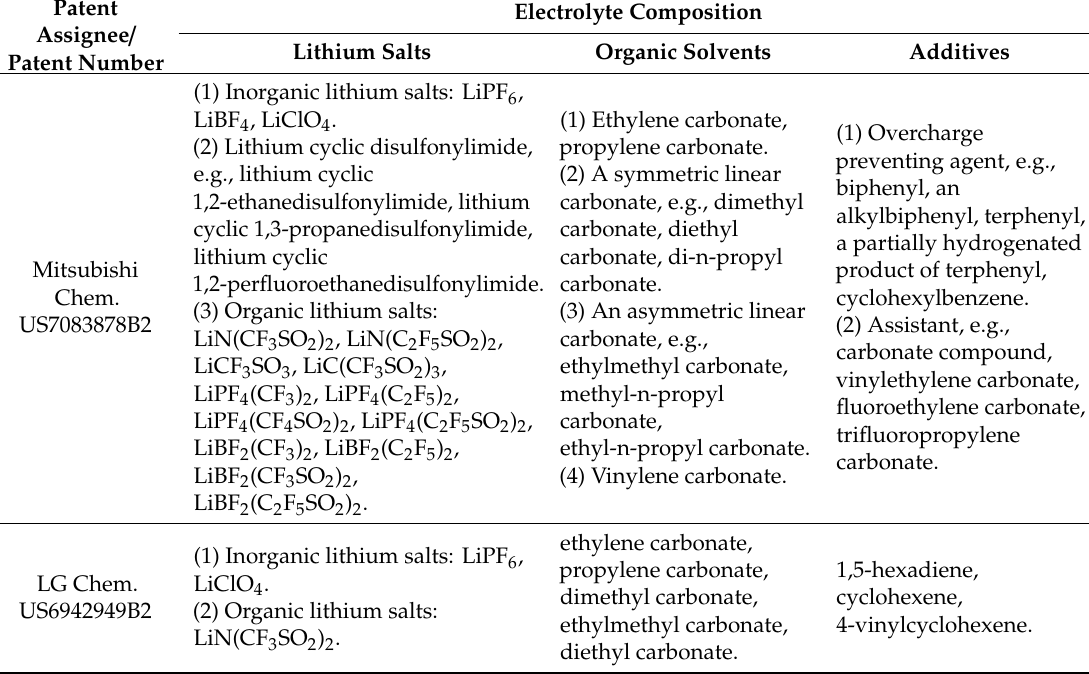
Table 2. Patent information extracted from two patents with the highest forward citation